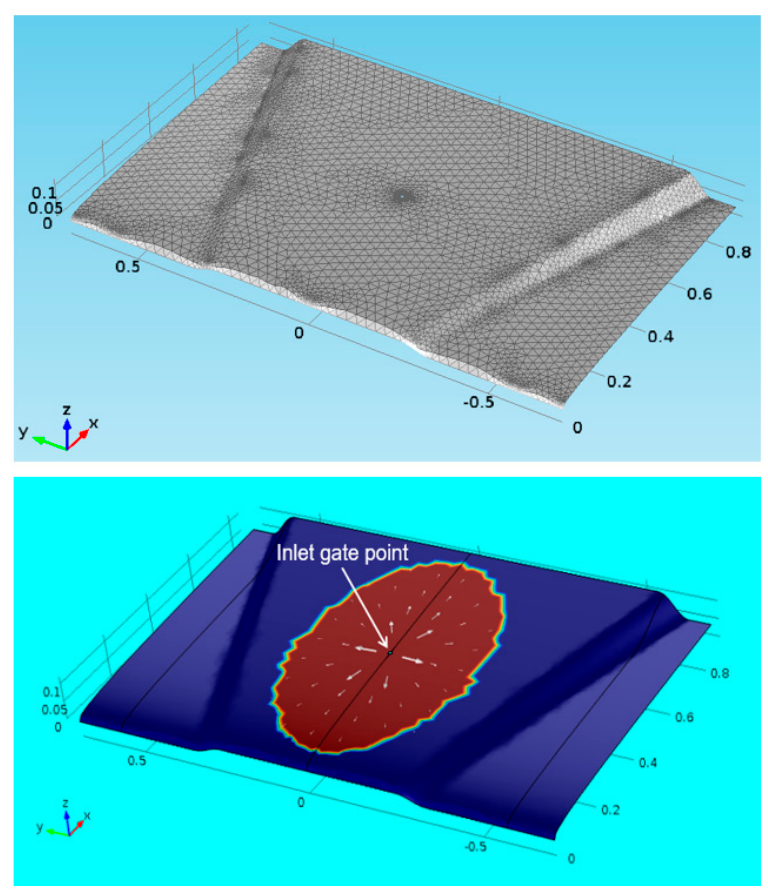
Figure 7. First geometry ( top picture ) and injection simulation ( bottom picture ) of composite vehicle hood (distances are given in meters). Table 5. Fill times and injectability numbers for filling cases of the first hood